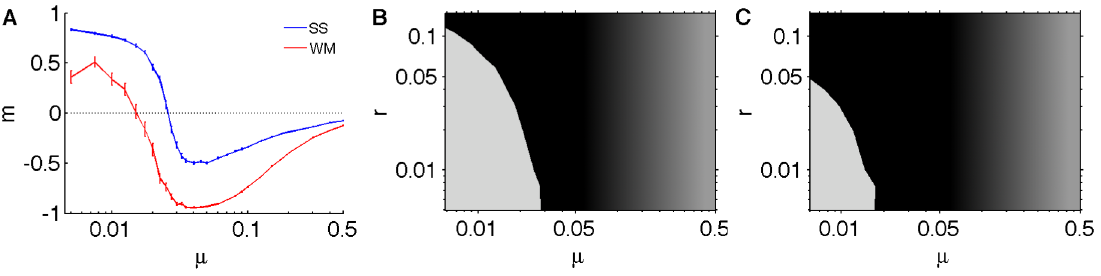
Figure 2. Transitions in strategy space. ( A ) The order parameter m defined in Eq. [1] as a function of the mutation rate for a spatially-structured and a well-mixed population, obtained from play statistics averaged over 80 independent runs each (see Text S2). Errors are two standard errors. ( B ) Qualitative phase diagram as a function of m and r for spatially-structured populations, where light grey indicates cooperation and black indicates defection. ( C ) Phase diagram for well-mixed populations. Both phase diagrams with quantitative levels of cooperation are shown in Fig. S4.